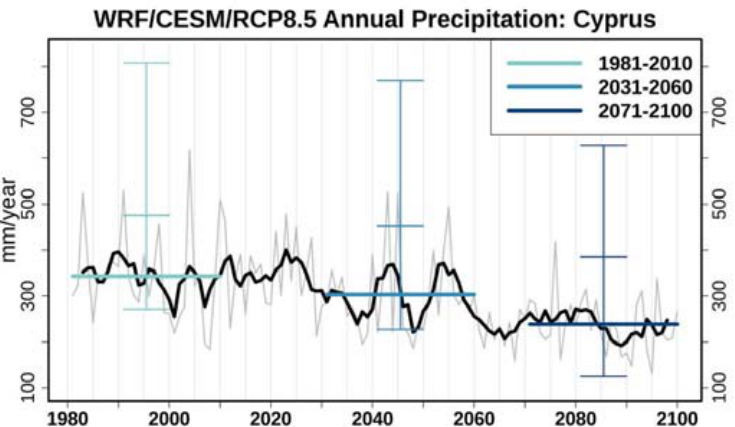
Figure 2. Observed ( top left ) and simulated ( top right ) annual precipitation total for the period 1981 to 2010 and projected changes for the middle ( bottom left ) and end of the 21st century ( bottom right ).